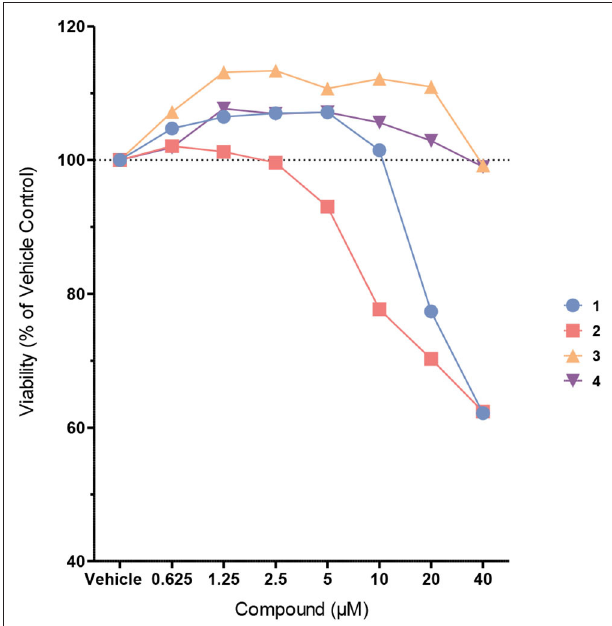
FIGURE 4 | Cell viability of immortalized murine bone marrow-derived macrophages after treatment with probes 1 – 4 . Cells were treated with the probes at different concentrations in Opti-MEM for 4h. Cell viability was assessed using the CellTiter-Blue cell viability assay.